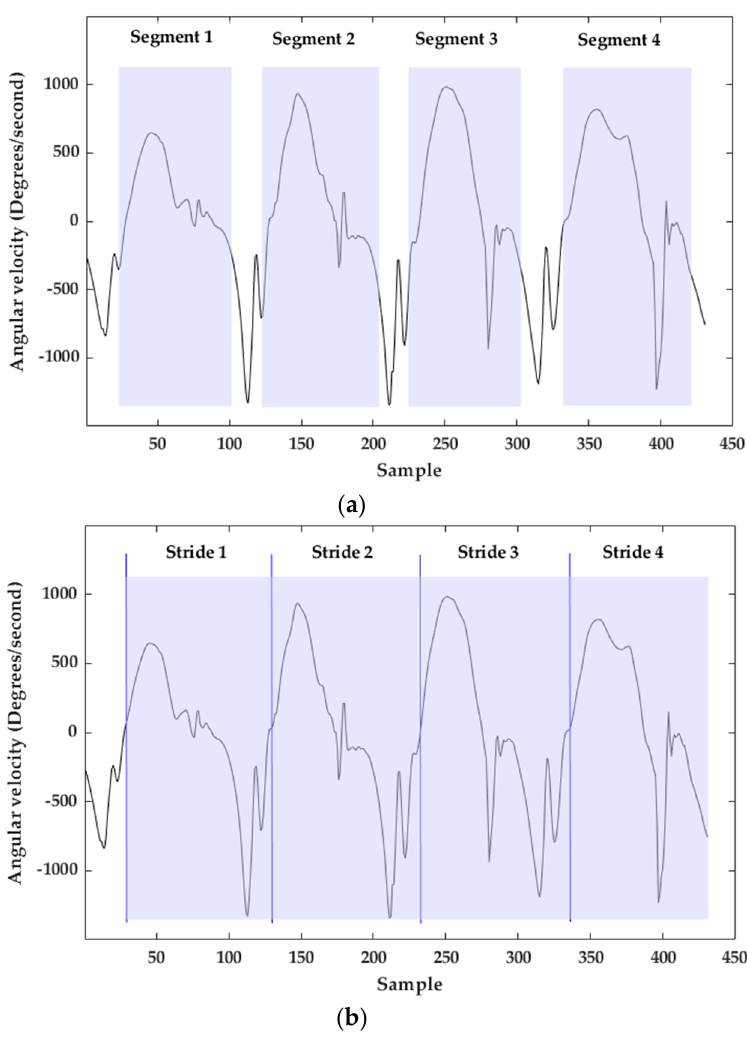
Figure 6. ( a ) Result of stride segmentation with msDTW. ( b ) Final stride segmentation with TO detection. Blue vertical lines depict TOs. Light blue rectangles are segmented strides.